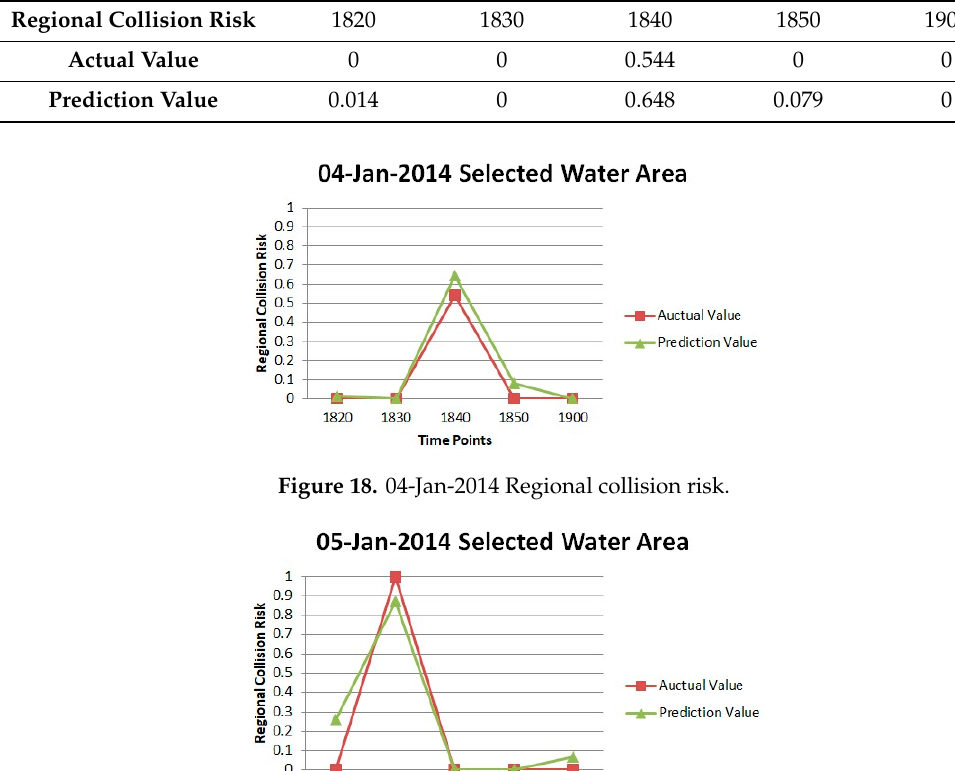
Table 8. 04-Jan-14 Regional Collision Risk.